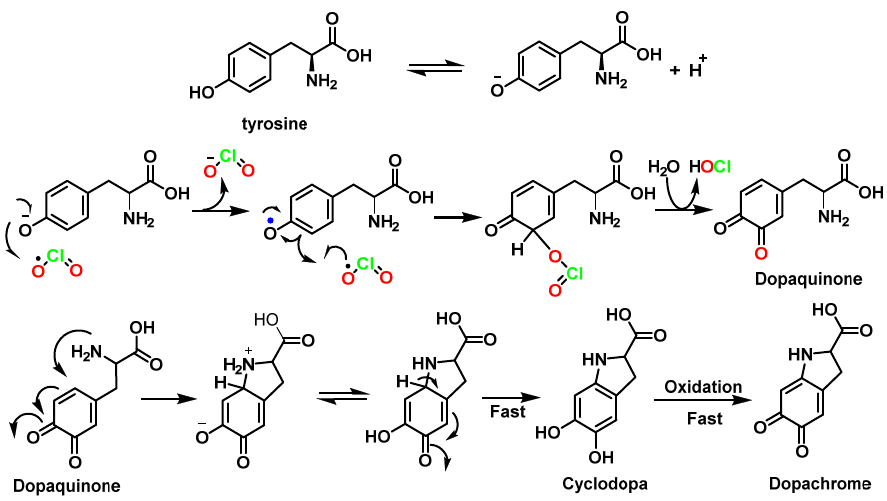
Figure 38. Reaction pathways proposed for ClO 2 oxidation of the amino acid tyrosine.